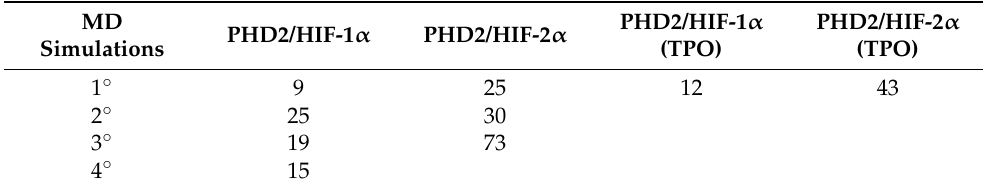
Table 2. Total cluster numbers of PHD2/HIF-1α, PHD2/HIF-2α, PHD2/HIF-2α with Thr405-P (TPO), and PHD2/HIF-2α with Thr405-P (TPO).